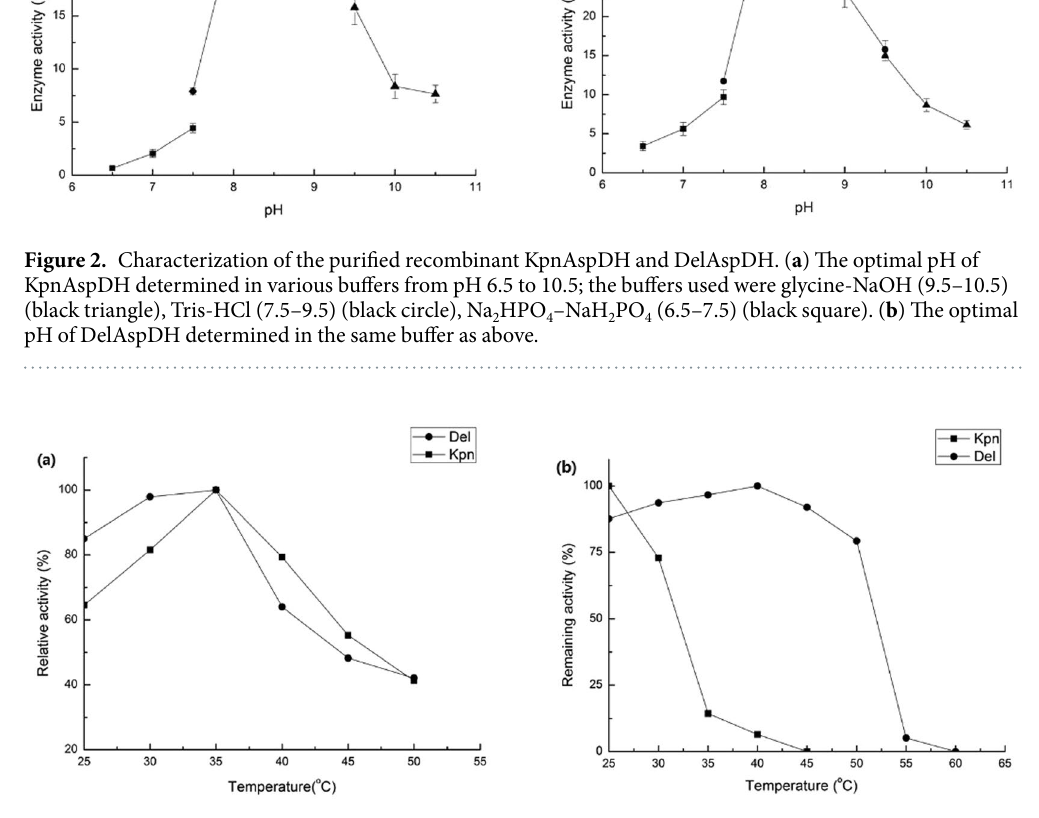
Figure 3. Characterization of the purified recombinant KpnAspDH and DelAspDH. ( a ) Optimal temperature measured in 100 mM Tris-HCl at pH 8.5 and 8.0, respectively. ( b ) Thermostability determined by measuring the residual activity after preincubation in temperatures ranging from 25 to 60 °C for 20 min.